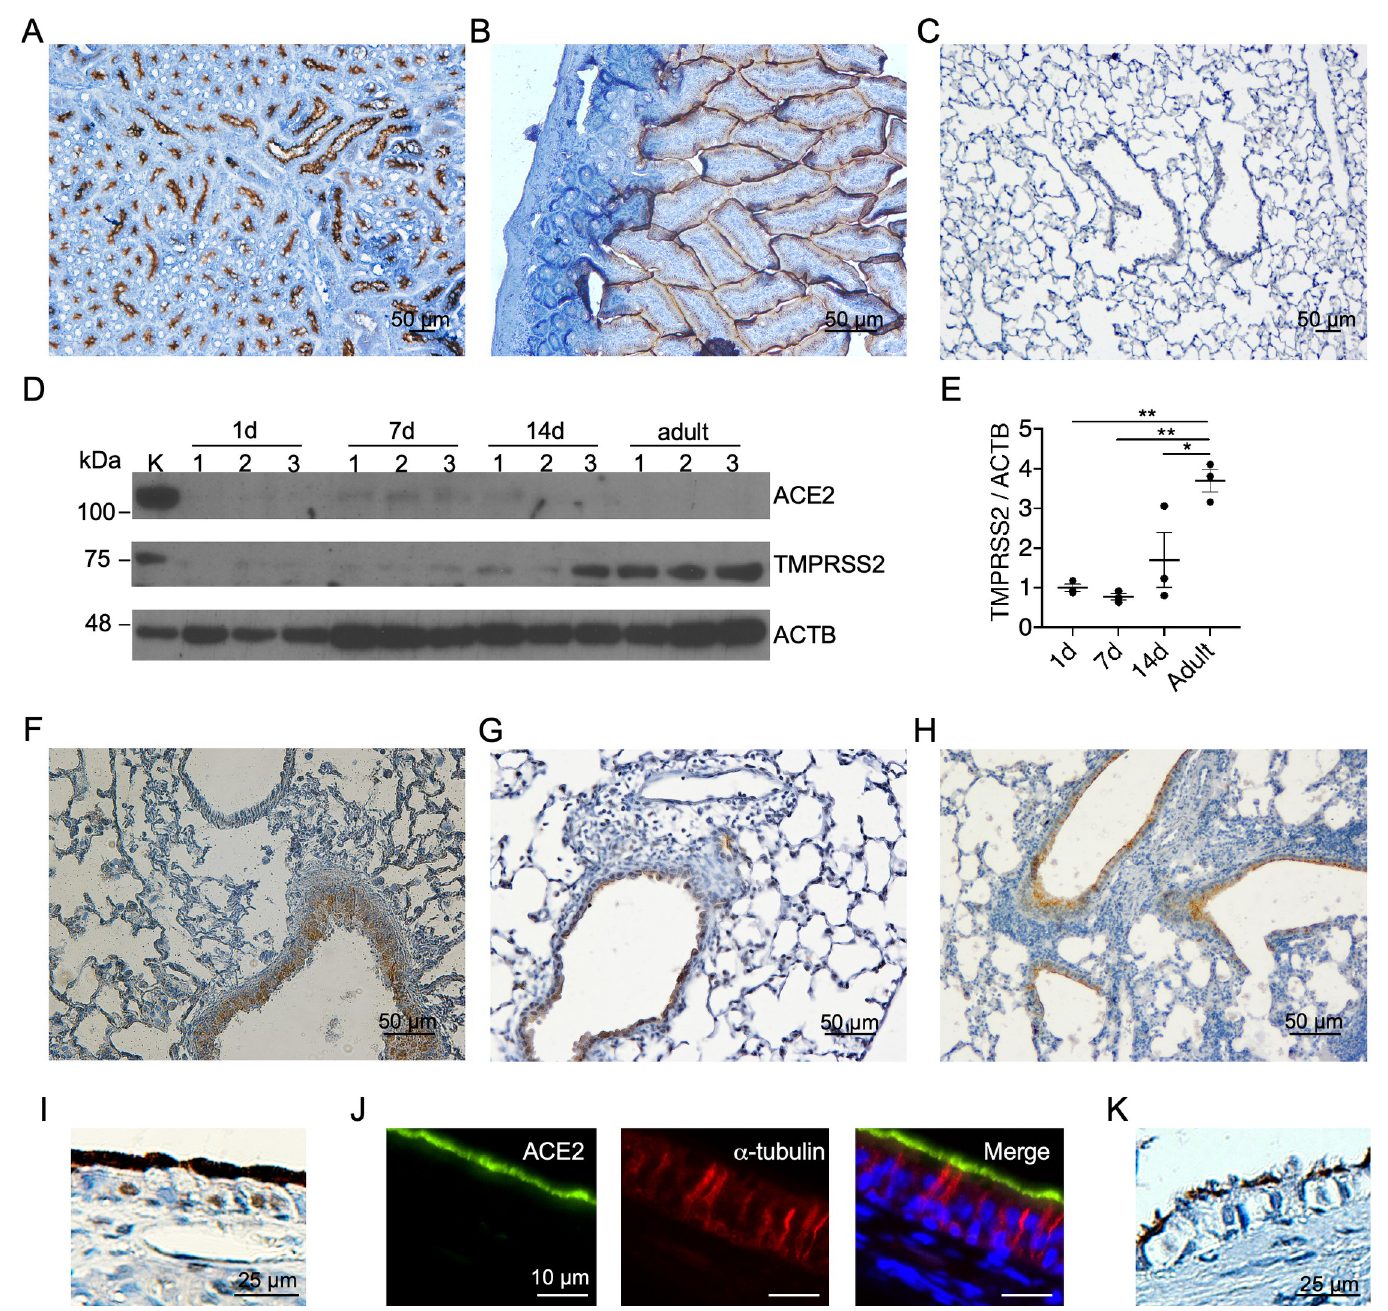
Fig 4. ACE2 is constitutively expressed in F433/N rat nasal mucosa and lungs, and induced in murine lungs with injury. Representative IHC for ACE2 in adult murine kidney (A), intestine (B), and lung (C). Representative IHC for ACE2 (J) and double IF for ACE2 and α -tubulin on F433/N rat nasal mucosa sections (K) and IHC for ACE2 on F433/N lung section (L). Immunoblotting and densitometry of murine whole lung homogenates from newborn and adult mice demonstrate TMPRSS2, but not ACE2 expression in adult samples (D & E). Representative adult murine lung sections with acute lung injury induced by hyperoxia exposure (F) and P . aeruginosa pneumonia (G), and ovalbumin-induced allargic airway inflammation (H) demonstrate diffuse ACE2 immunoreactivity in bronchial epithelial cells. Representative IHC for ACE2 (I) and double IF for ACE2 and α -tubulin on F433/N rat nasal mucosa sections (J) and IHC for ACE2 on F433/N lung section (K).